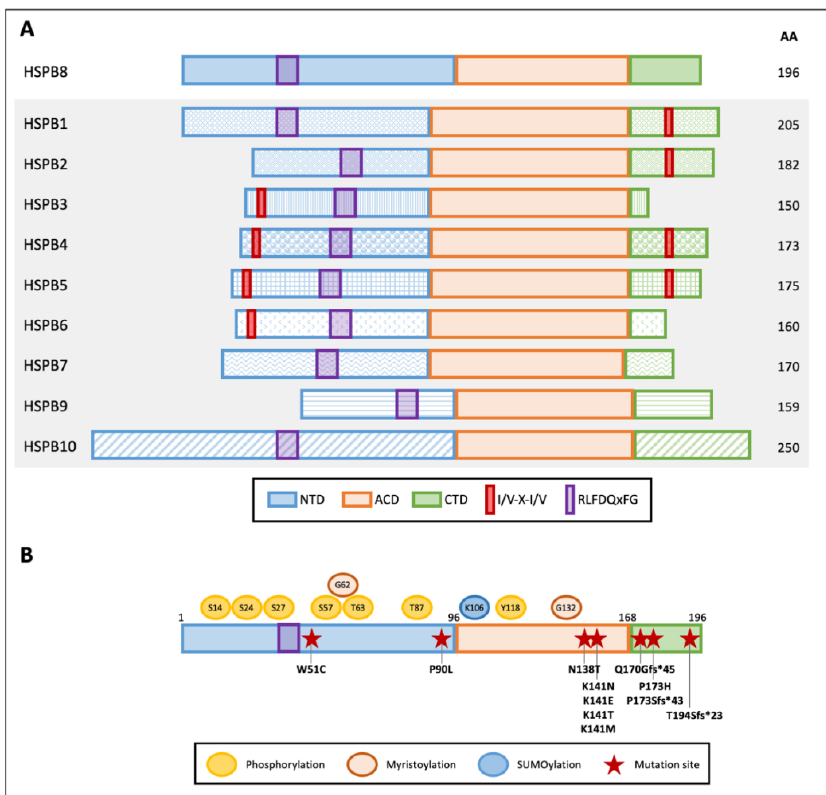
Figure 1. Graphical representation of human small heat shock proteins (HSPBs) structure and features. ( A ) Schematic diagram of the domains within human HSPBs. NTD and CTD indicate the variable N- and C-terminal domains, respectively; ACD indicates the conserved alpha-crystallin domain. Red boxes and purple boxes indicate the I/V-X-I/V motifs and the RLFDQxFG conserved sequence, respectively. Amino acid length is indicated on the right. ( B ) HSPB8 schematic structure, post-translational modifications, and mutations. Post-translational modification residues are reported: phosphorylation sites are indicated in yellow, predicted myristoylation sites in orange, and a SUMOylation site in light blue. Red stars indicate HSPB8 mutations reported in the literature.